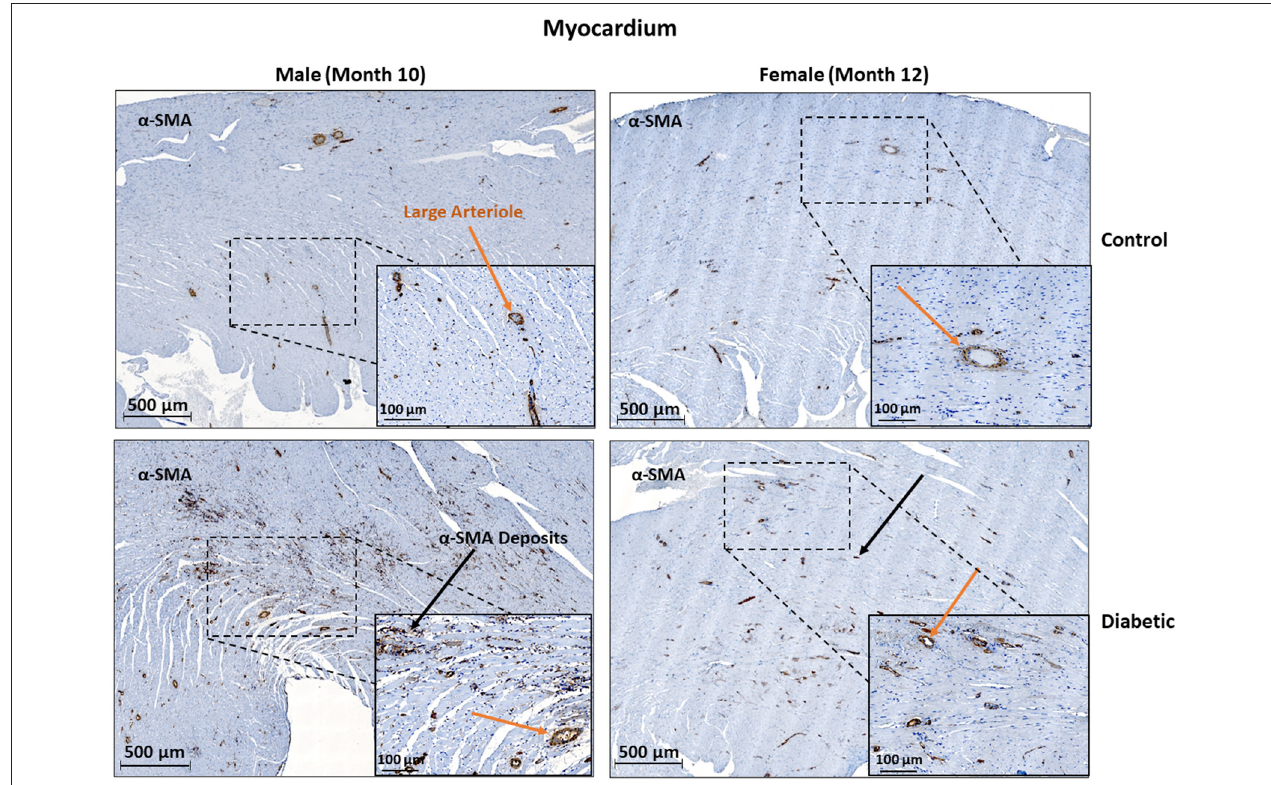
FIGURE 7 | Histology of large arteriole perivascular smooth muscle wall in the myocardium shows no thickening in either sex. Representative images of LV cardiac muscle sections stained with α SMA in males at 10 months and females at 12 months post-induction. A substantial amount of myofibroblast deposits is seen in diabetic males and, to a lesser degree, in diabetic females (black arrows). No difference was observed in large arteriole smooth muscle wall thickness (orange arrows).